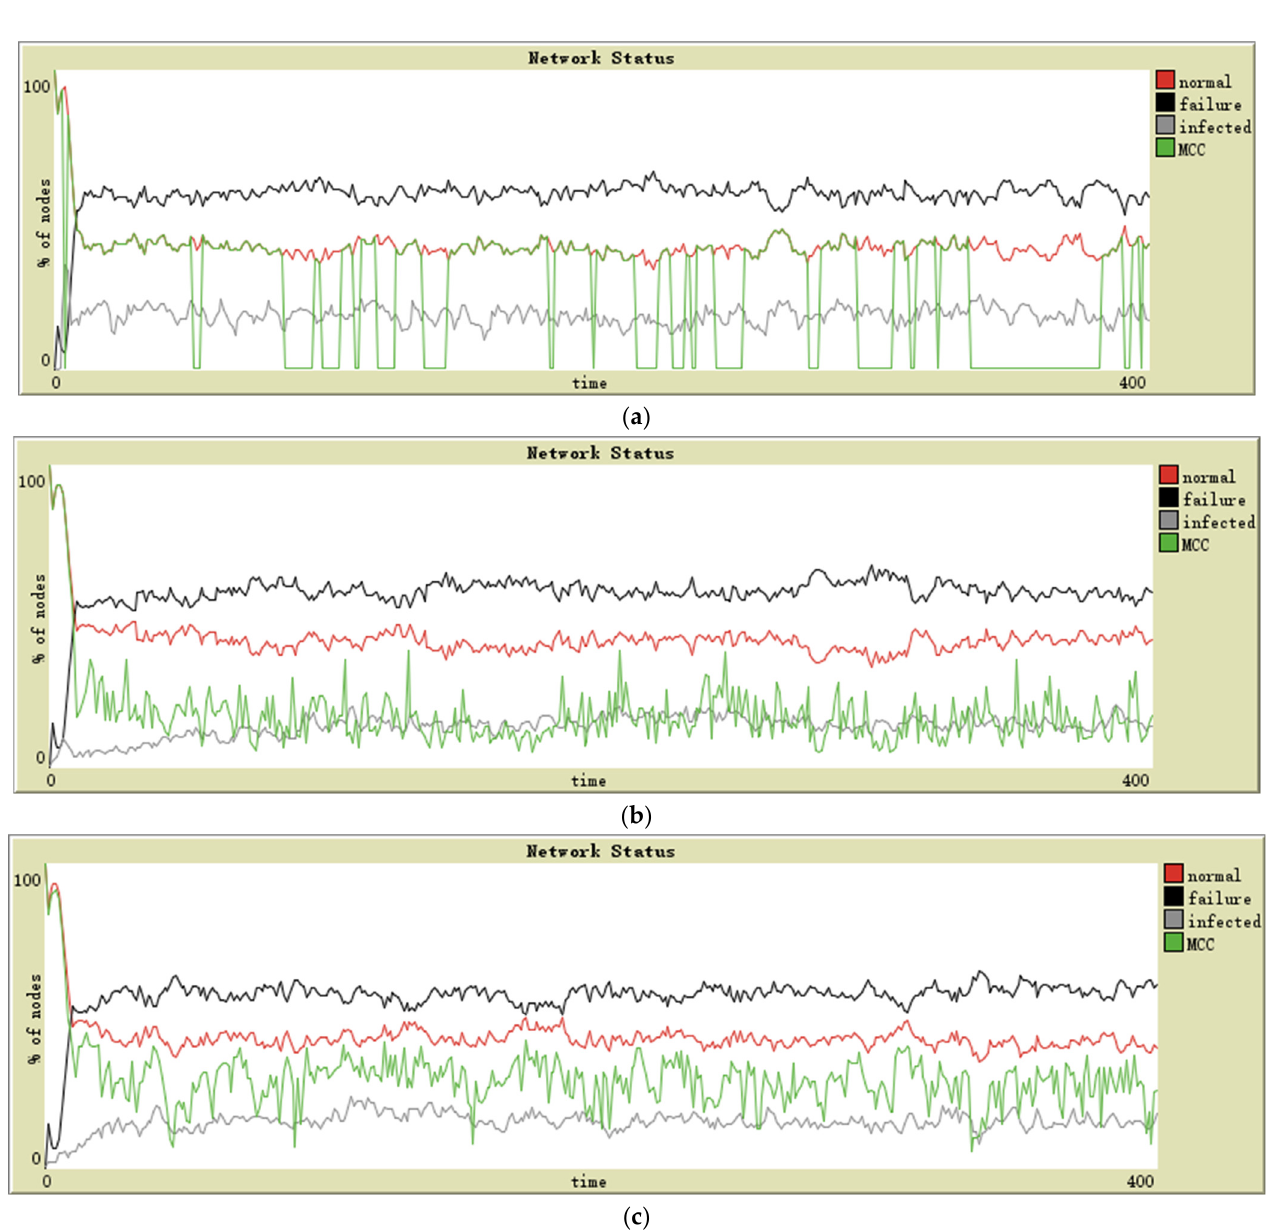
Figure 5. Simulation on Smart Home in ( a ) star topology, ( b ) lattice-2d topology, and ( c ) random topology.